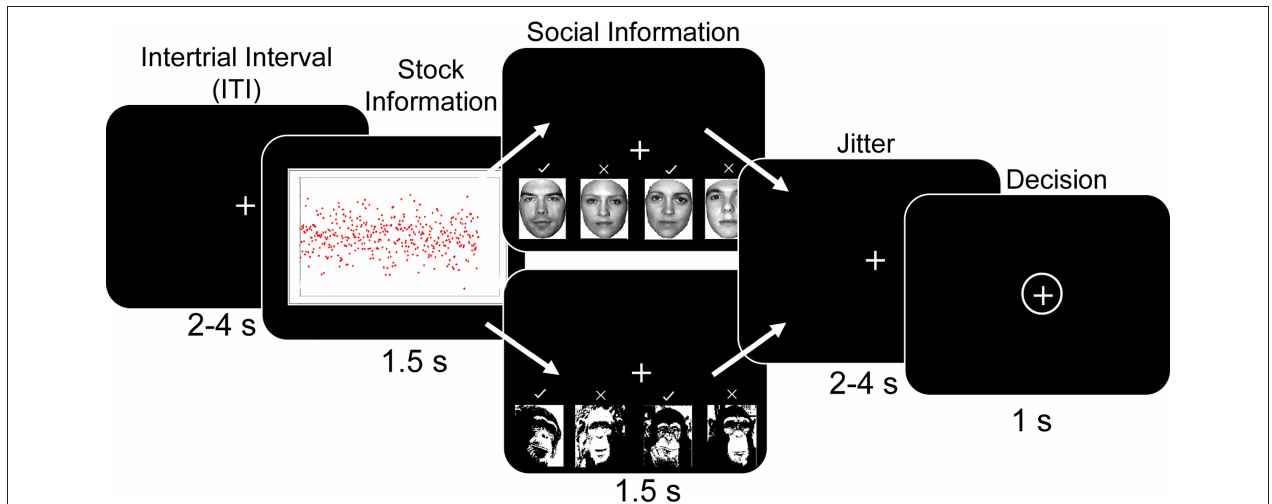
checkmarks or x-marks above the faces. Four different social conditions were used; everyone buys (“ + 4”), a split group (2 − 2), everyone does not buy (“ − 4”) and a scrambled decision with no discernable information (no social, “NS”). On half the trials chimpanzee faces were presented with the same social conditions as a non-human, non-social control situation. After a jittered interval of 2–4 s the participant made a decision to “adopt” or “reject” the stock using the button box when the fixation cross was